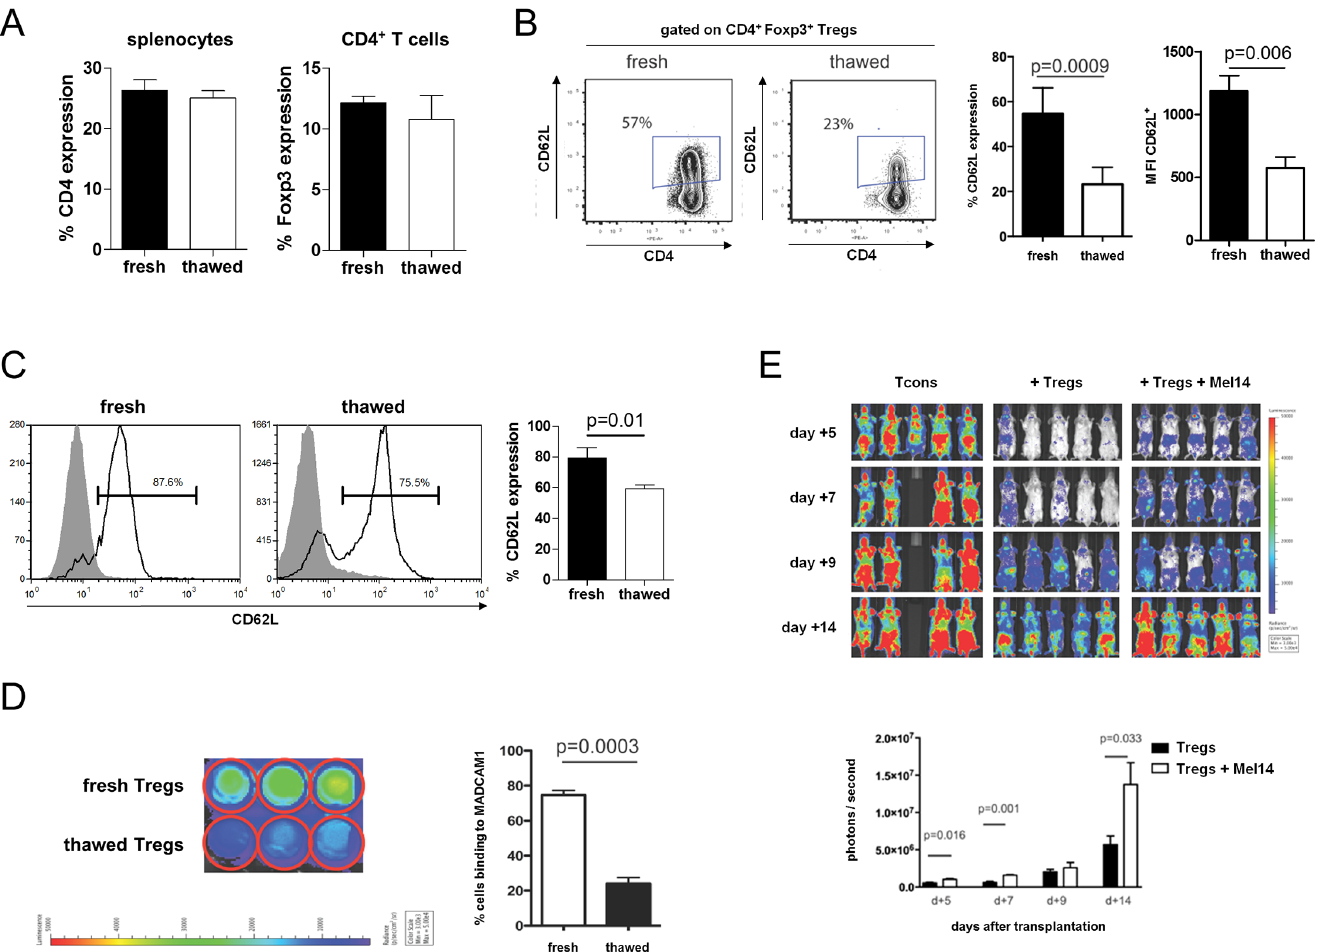
Fig 1. Thawing of frozen Tregs reduces CD62L expression and inhibits the binding to MADCAM1. ( A ) Relative number of CD4 + T cells among live splenocytes and Tregs among CD4 + T cells before freezing and after thawing. ( B ) Representative dot plots illustrating CD62L expression on Tregs before freezing and after thawing. Dot plots are gated on live CD4 + Foxp3 + T cells. Relative number of CD62L expressing cells among Tregs. Mean fluorescence intensity (MFI) of fluorescein isothiocyanate coupled to Anti-CD62L of CD62L + Tregs. Shown are 4 mice per group from one of at least two independent experiments. ( C ) Representative histograms showing CD62L expression on human CD4 + Foxp3 + Tregs before and after cryopreservation. Shown are 4 single donor samples per group. ( D ) Representative bioluminescence images of isolated Tregs that adhere to plate-bound MADCAM1 in vitro using Cell Titer Glo. Shown is one of at least two independent experiments performed in triplicates. ( E ) Representative bioluminescence images of luc + Tcons in mice receiving Tcons alone or Tcons with fresh Tregs incubated without or with CD62L-blocking antibody (Mel14) prior to transplantation. Shown are five animals per